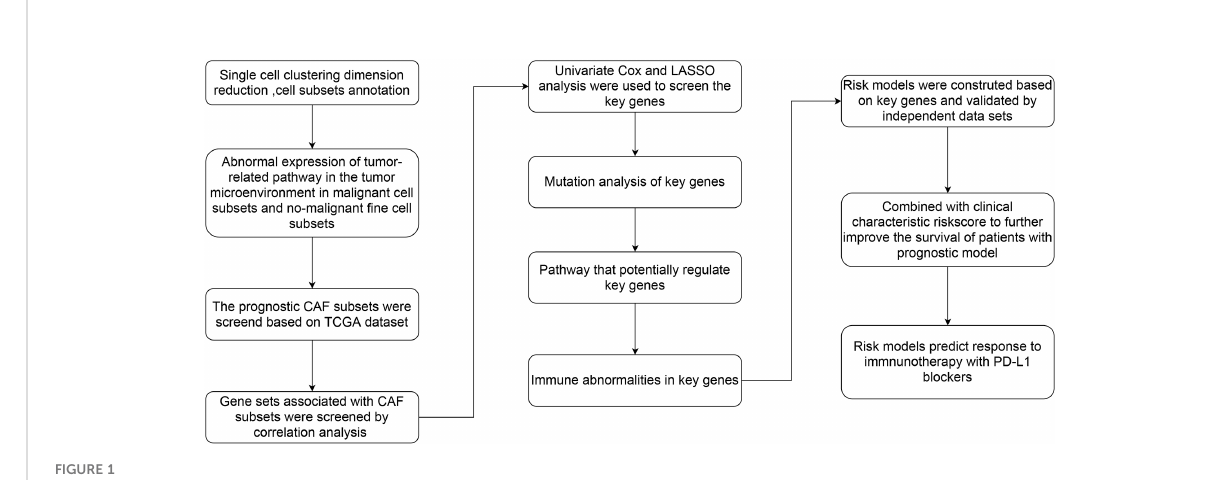
FIGURE 1 The fl ow chart of this